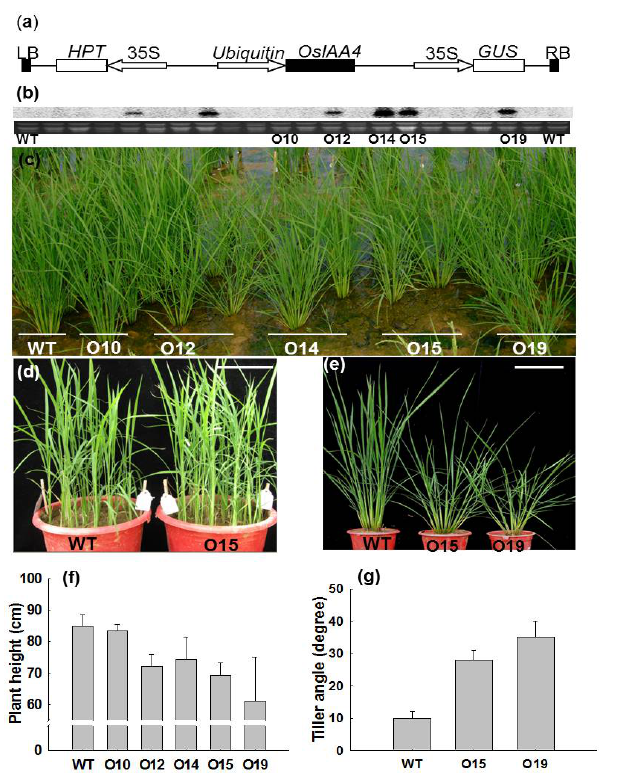
Figure 2. Morphological changes of OsIAA4 -overexpressed plants under normal growth conditions. ( a ) Over-expression construct for rice transformation; ( b ) RNA gel-blot analysis of the transgenic and wild-type plants; ( c ) Vegetative growth of wild-type, non-overexpressing transgenic line (O10) and OsIAA4 -overexpressed transgenic lines (O12, O14, O15 and O19) in field. scale bar in c = 9.5 cm; ( d ) WT and OsIAA4 -overexpressed (O15) line at seedling stage. scale bar in d = 17 cm; ( e ) Increased tiller angle and dwarfism of over-expressed plants (O15 and O19) compared to the wild-type plants; ( f ) Quantification of plant height; ( g ) Quantification of tiller angle. Error bars indicate SD, n =